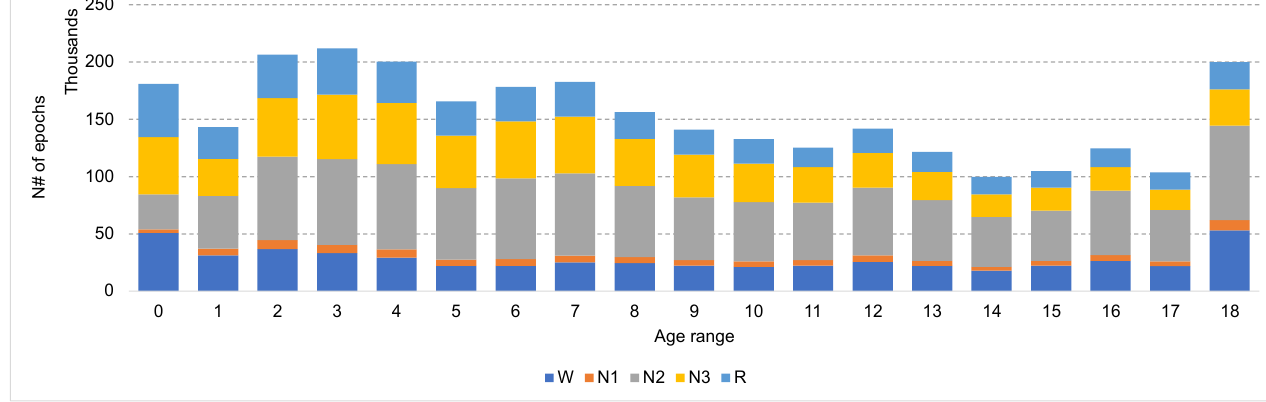
Figure 3. The distribution of the training data over different stages and age ranges.